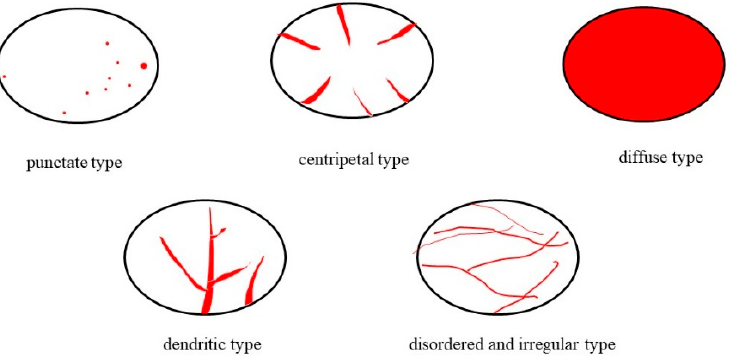
Figure 3. The entry mode of contrast medium at artery phase. The black circle represents the focus; red represents the distribution of contrast agent.